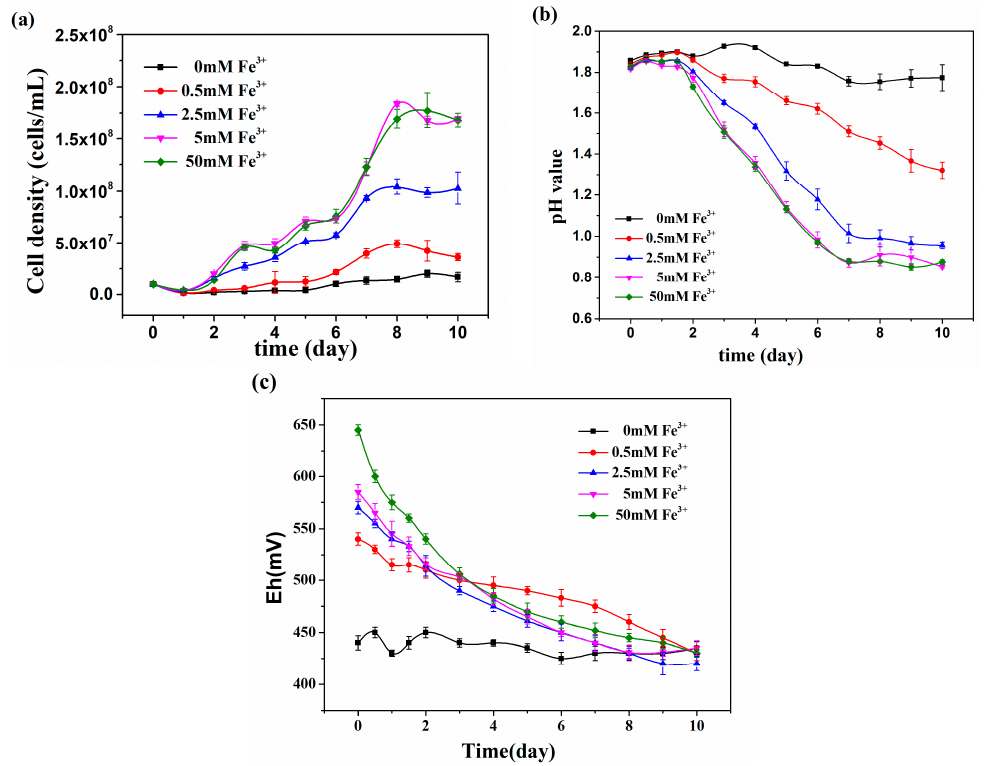
Figure 2. The effect of ferric iron on the cell density ( a ), pH value ( b ) and Eh ( c ) of At. thiooxidans A01 under the influence of 600 mM Ni 2+.